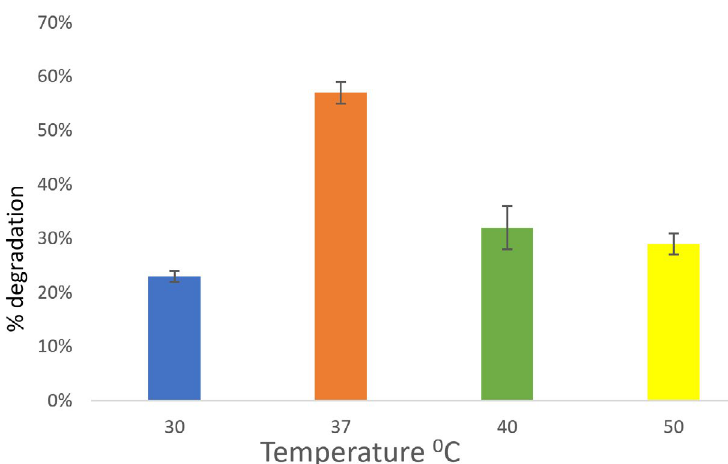
Fig. 6. Feather degradation by Bacillus pumilus at different